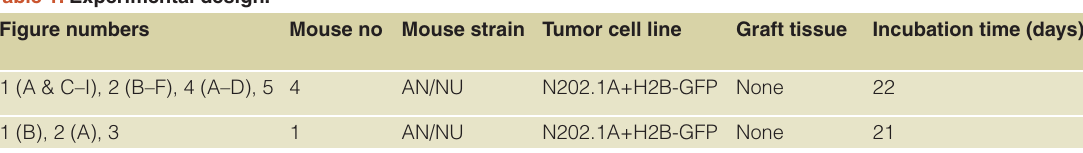
Table 1. Experimental design. Figure numbers Mouse no Mouse strain Tumor cell line Graft